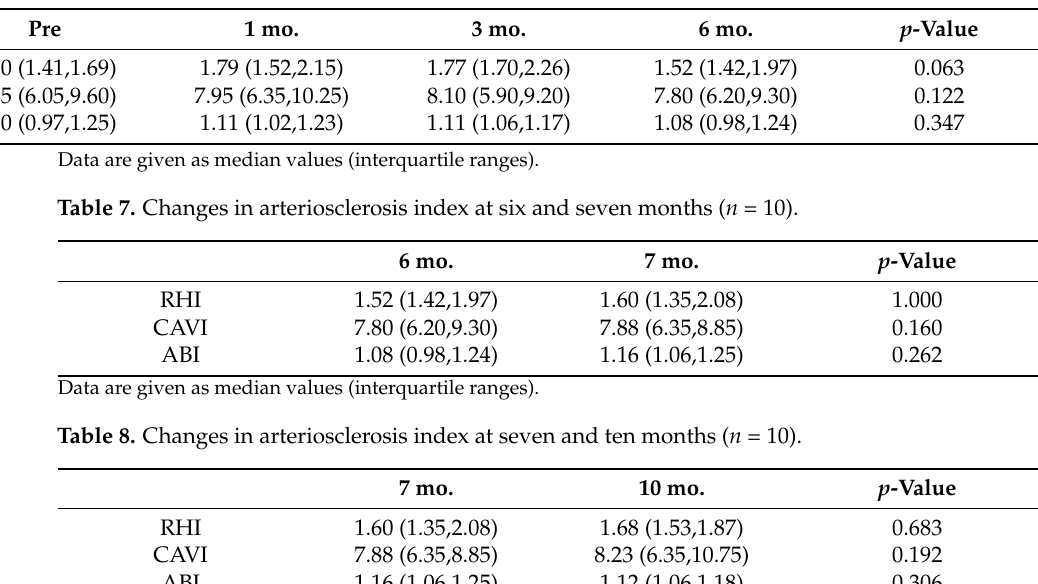
Table 6. Changes in arteriosclerosis index ( n = 10).